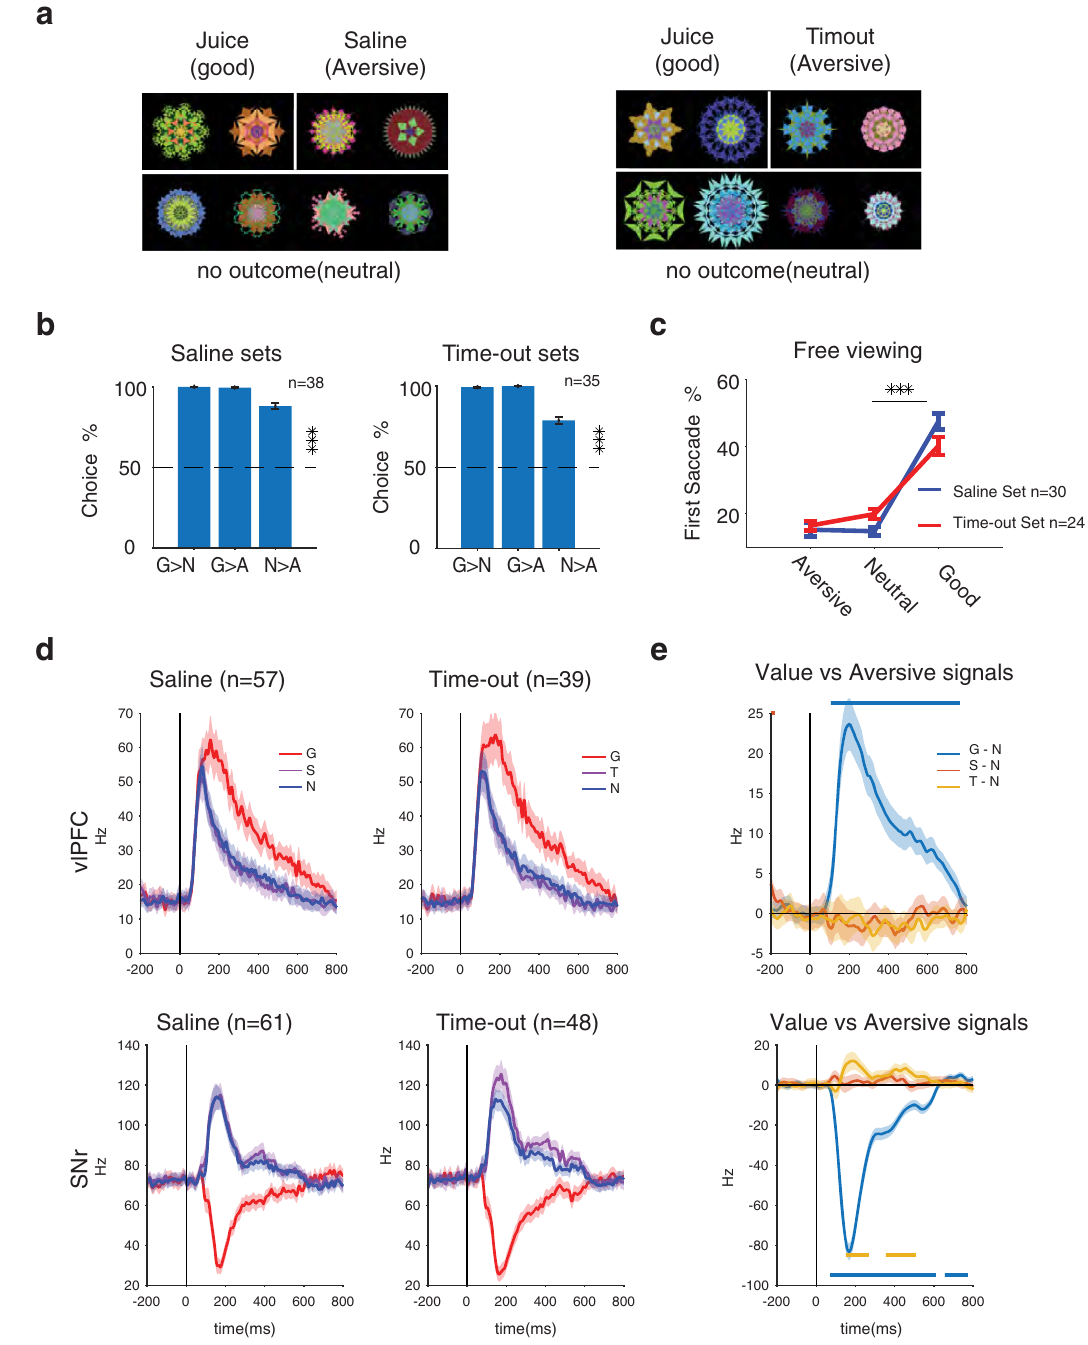
Fig.4|ResponsesofvlPFCandcdlSNrtosalineandtimeoutassociatedobjects